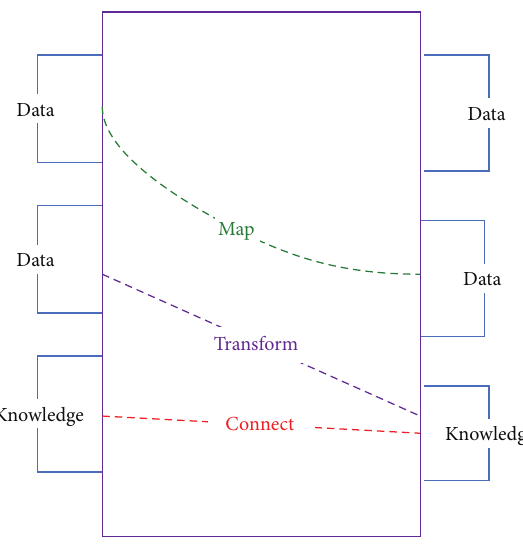
Figure 4: Three typical Mappings in an